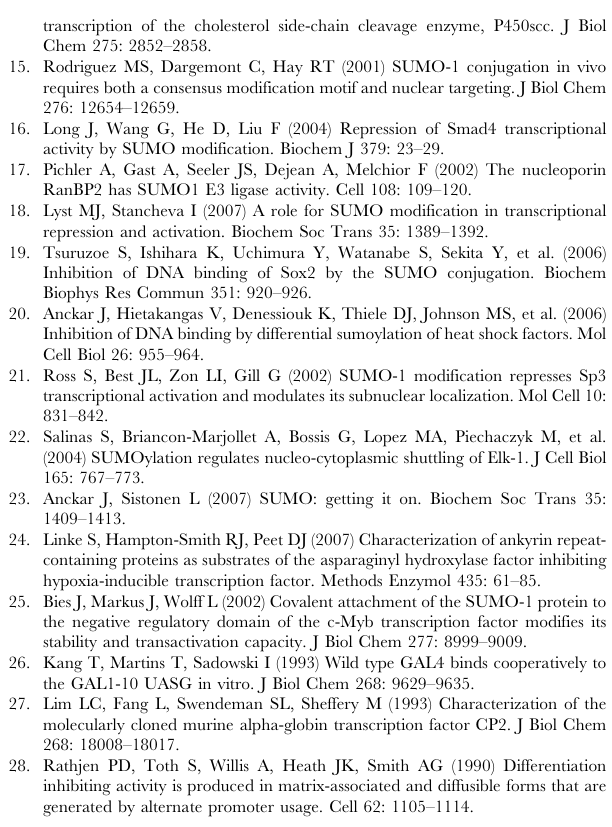
Figure S1 A. CRTR-1 activates transcription in ES cells. Cells were co-transfected with pTK-4xWT-CP2-LUC and pEF-CRTR- 1 expression plasmid (CRTR-1) as indicated. Relative luciferase activity was determined by normalisation to renilla activity. The data are presented relative to the activity of the reporter vector alone and are the mean 6 SEM of two independent experiments, each of which was conducted in triplicate. Note: fold activation seen here is higher than that seen in the comparable experiments in Figure 1. Our evidence suggests that this difference is likely to be due to a change in DNA preparation method between the experiments. Endotoxin-free DNA was used for all transfections, apart from those in S1A. B. Western blot analysis of ES, HEK293T and COS-1 cells transfected with pTK-4xWT-CP2- LUC and pEF-CRTR-1 expression plasmid (CRTR-1) as indicated. Cells were lysed 48 h post-transfection and 20% of total cell lysate was analysed. The upper panel shows membrane probed with rabbit anti-LBP-9 antibody (LS-C30155, LifeSpan Biosciences, 1:500) and detected using enhanced chemifluores- cence. The lower panel is a re-probing of the membrane with rat anti-alpha-tubulin antibody and detection using chemilumines- cence. Figure S2 Western blot analysis of CRTR-1, FLAG-CP2, FLAG-NF2d9 and FLAG-altNF2d9 expression levels. Western blot analyses were performed on 30% of the HEK293T cell lysate